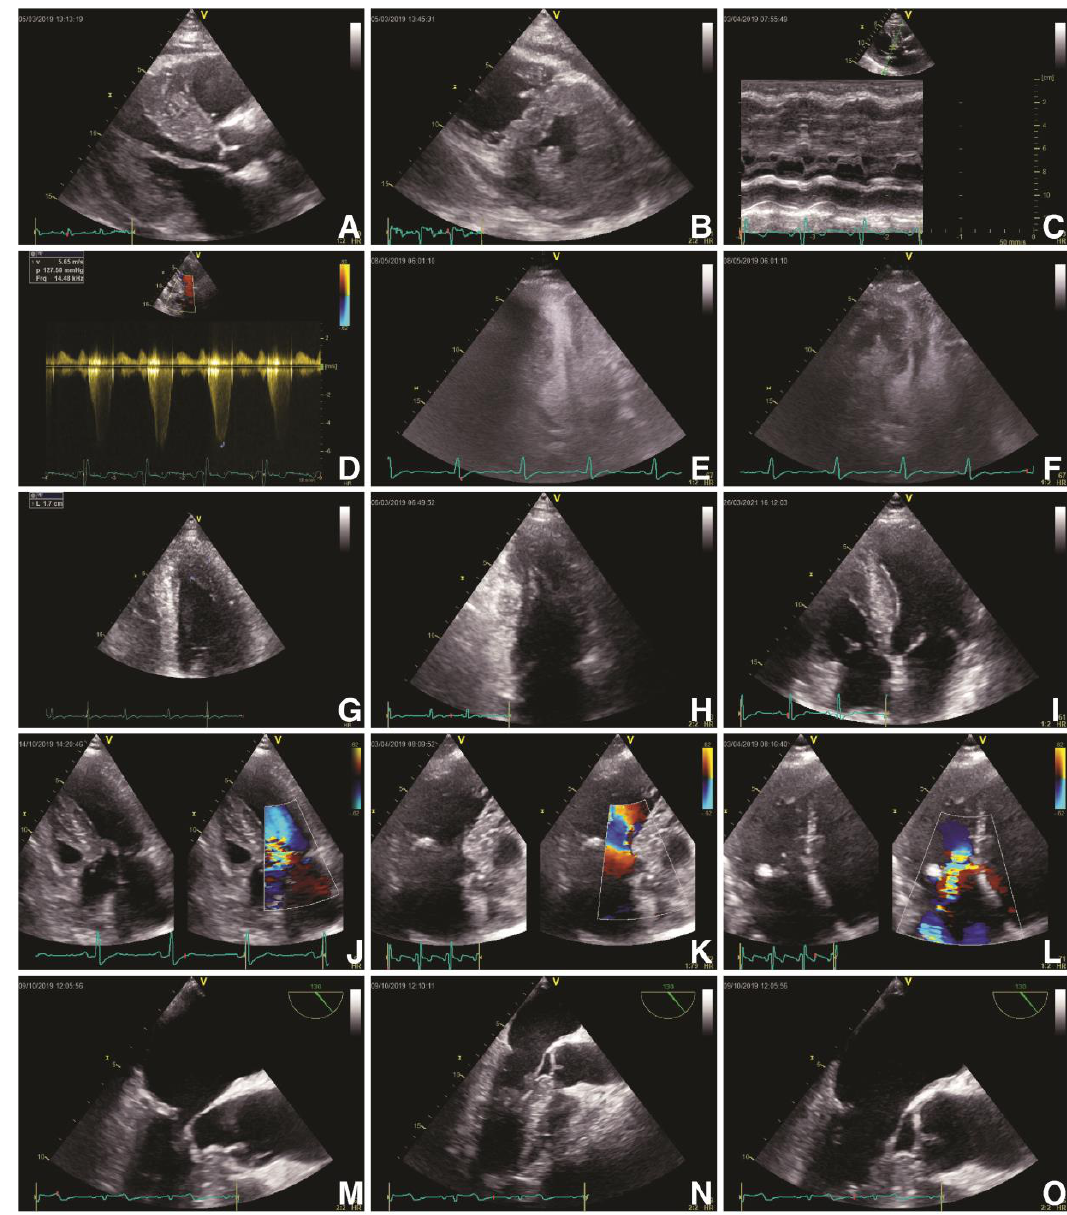
Figure 1. Echocardiographic findings in hypertrophic cardiomyopathy. TTE: obstructive HCM (Maron type III) in PLAX ( A ) and PSAX ( B ) views with an IVS of 23 mm and a ILW of 19 mm, with SAM of MV’s anterior leaflet in PLAX M-Mode ( C ) and a LVOT gradient of 127 mmHg and velocity of 5.65 m/s ( D ); contrast transthoracic echocardiography of a HCM with mid-cavity obstruction and apical LV aneurysm in A4C in systole ( E ) and diastole ( F ); HCM (Maron type IV) with isolated hypertrophy (18 mm) of the apical segment of LV’s lateral wall ( G , H ); non-obstructive HCM (Maron type II) with isolated hypertrophy of the IVS (20 mm) ( I ); obstructive HCM with SAM of the MV’s anterior leaflet and of its chordae tendineae with leads to severe MR ( J – L ). TEE: obstructive HCM with SAM of MV’s anterior leaflet—A2 scallop ( M – O ). Abbreviations: A4C, apical four-chamber view; HCM, hypertrophic cardiomyopathy; IVS, interventricular septum; LV, left ventricle; LVOT, left ventricle outflow tract; MV, mitral valve; PLAX, parasternal long-axis view; PSAX, parasternal short-axis view; SAM, systolic anterior movement; TEE, transoesophageal echocardiography; TTE, transthoracic